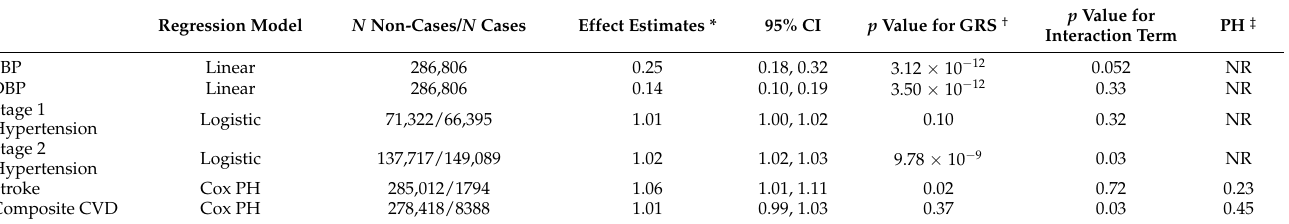
Table 2. Overview of the association of alcohol GRS with blood pressure, hypertension, and incident CVDs.